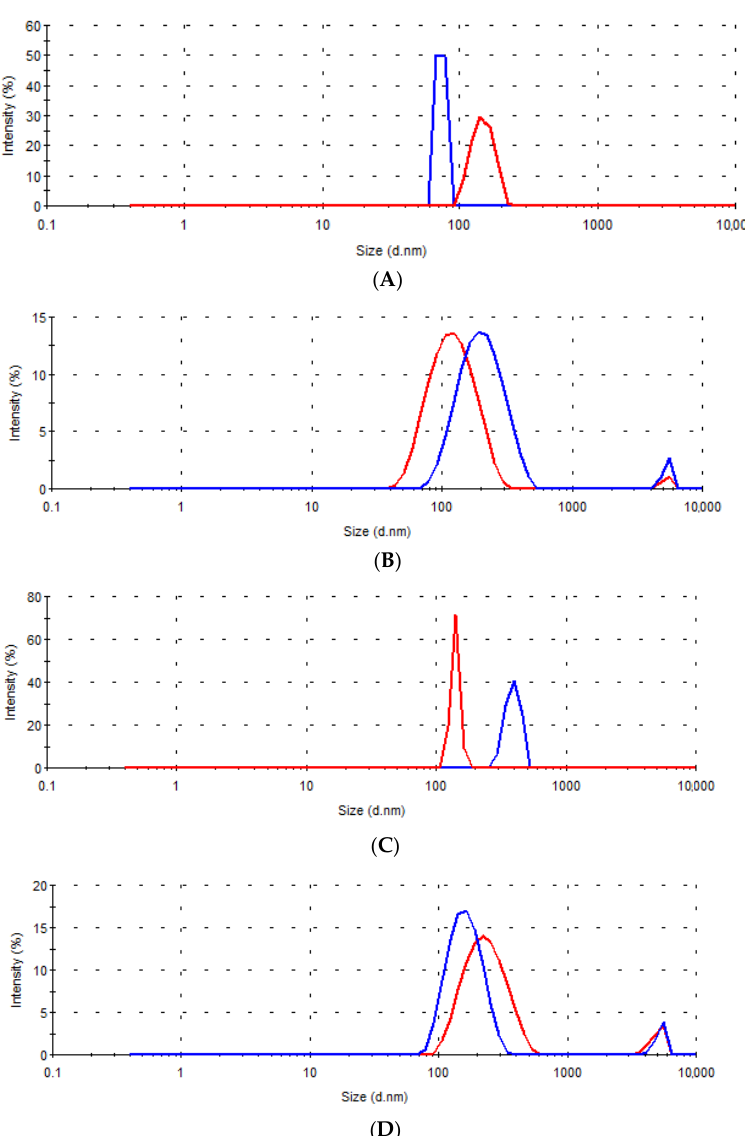
Figure 7. Size distribution by intensity in the dissolution media samples collected after 15 min (—-) and 6 h (---) for the tablets ( A – D ).